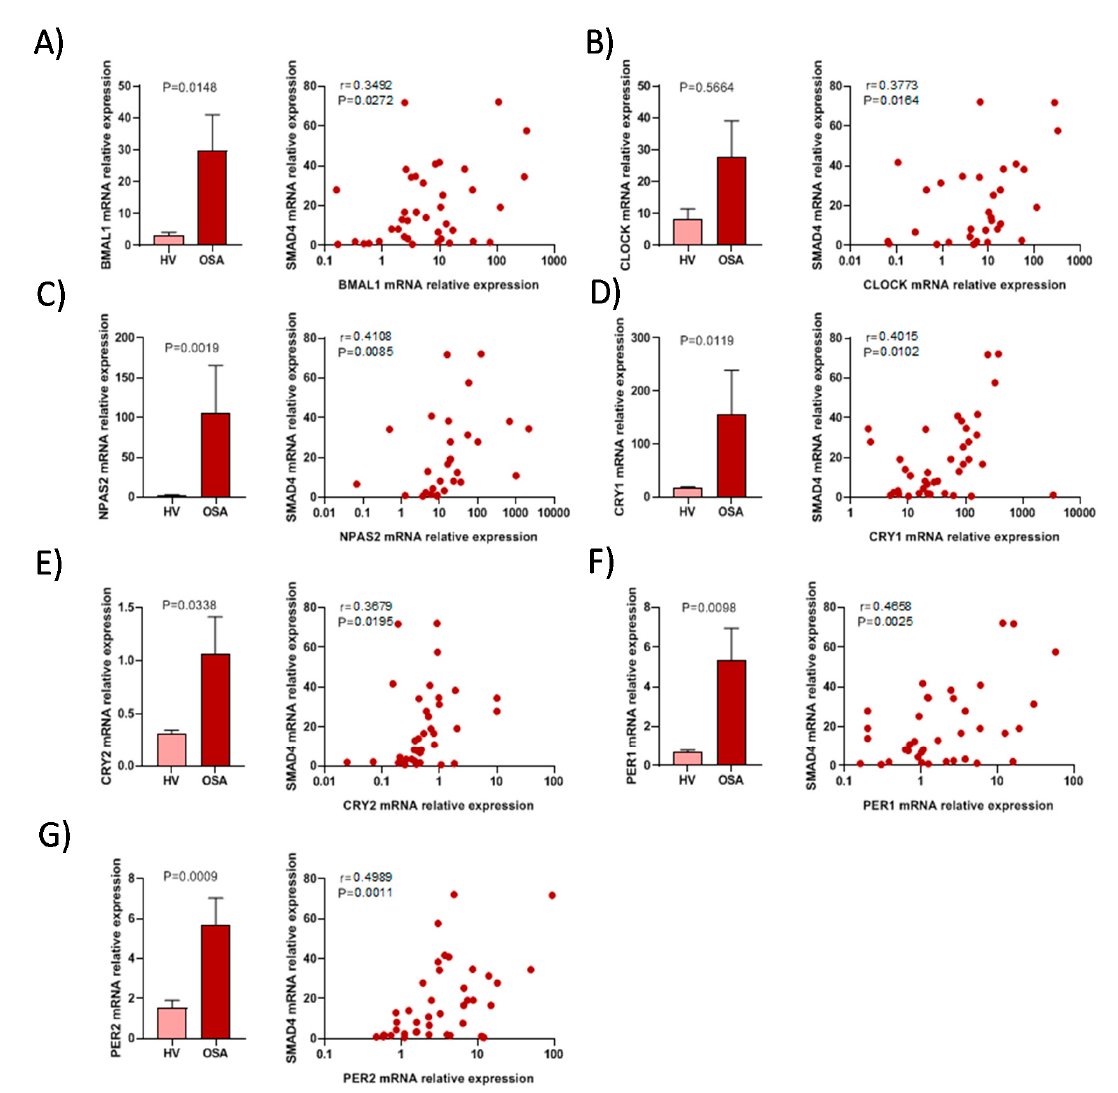
Figure 3. Circadian rhythm variation is related to SMAD4 expression in OSA patients. Relative mRNA expression in monocytes from OSA patients (OSA) ( n = 40) and healthy volunteers (HV) ( n = 18). Correlation between relative expression of circadian genes mRNA (BMAL1 ( A ), CLOCK ( B ), NPAS2 ( C ), CRY1 ( D ), CRY2 ( E ), PER1 ( F ) and PER2 ( G )) and of SMAD4 mRNA in monocytes from OSA patients ( n = 40). Comparisons between groups were performed by an unpaired t test with Welch’s correction. Means ± SEM are shown. Spearman’s correlation coefficients (r) and p -values are shown.